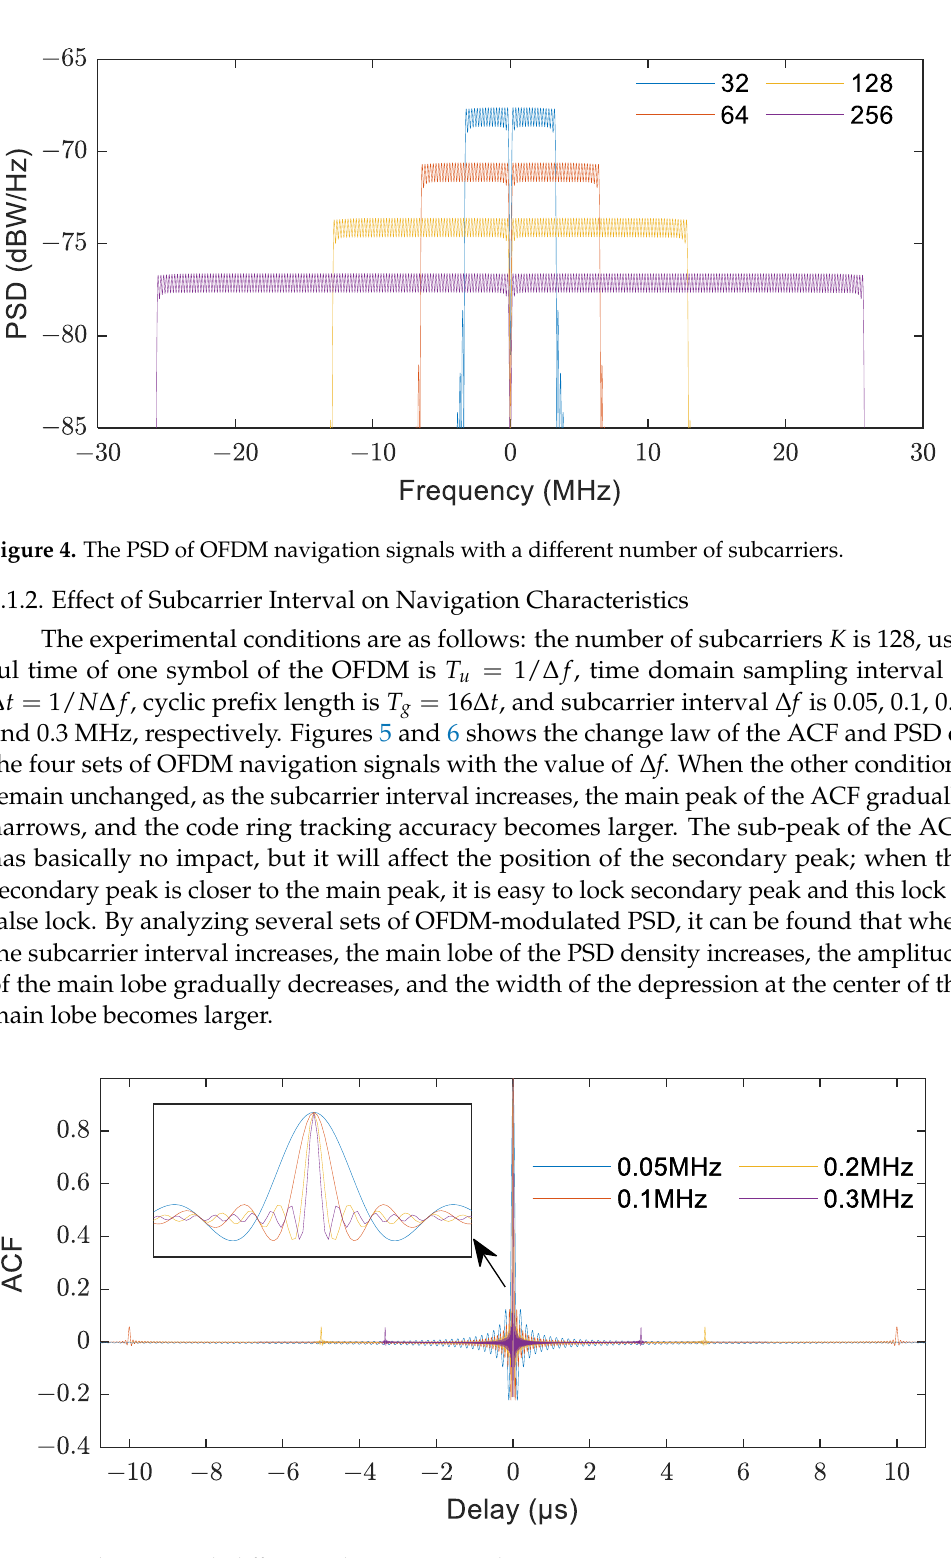
Figure 3. The ACF of OFDM navigation signals with a different number of subcarriers.